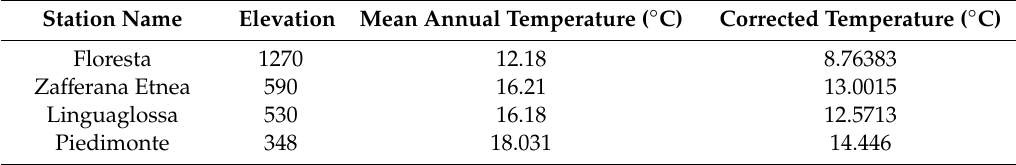
Table 6. Mean annual temperature (in ◦ C) and corrected temperature ( ◦ C) for the period